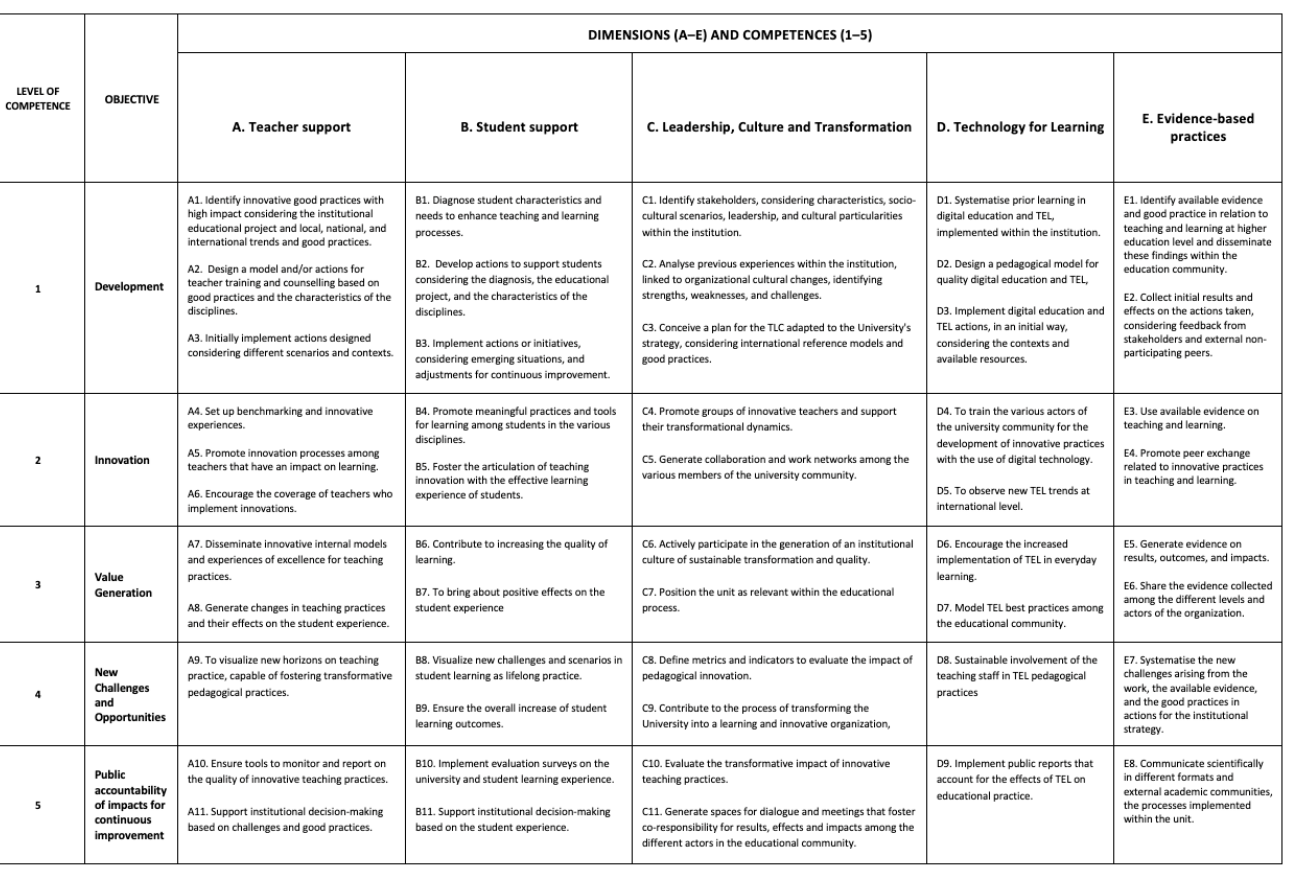
Figure 1. PROF-XXI Framework organizing the competencies of a TLC into five levels of competency and five dimensions. Extracted from [30].